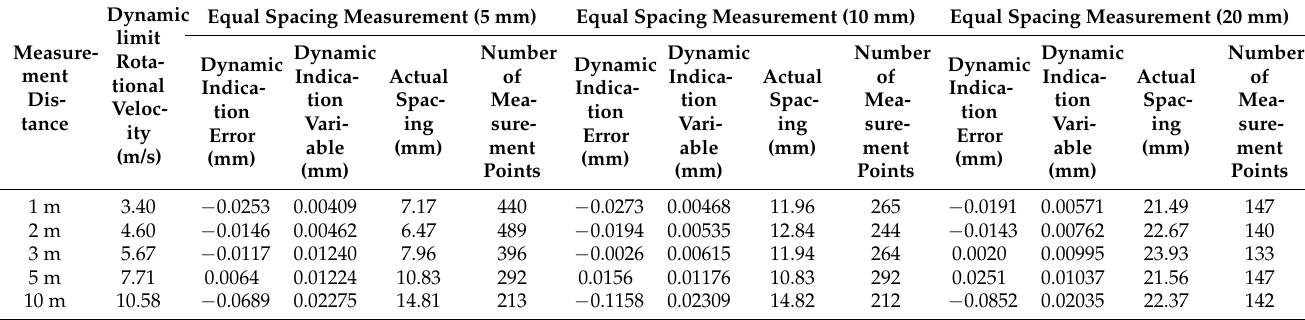
Table 1. The dynamic performance of the laser tracker when measuring at different distances and equal spacing.